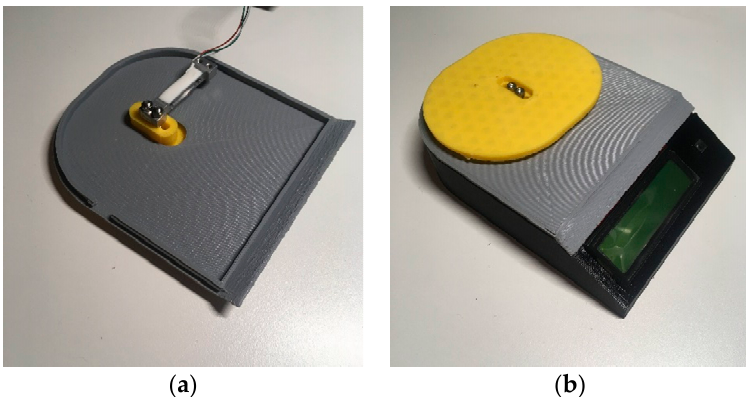
Figure 8. (a) The cover must be sandwiched between the load cell and the bed prior to attaching to